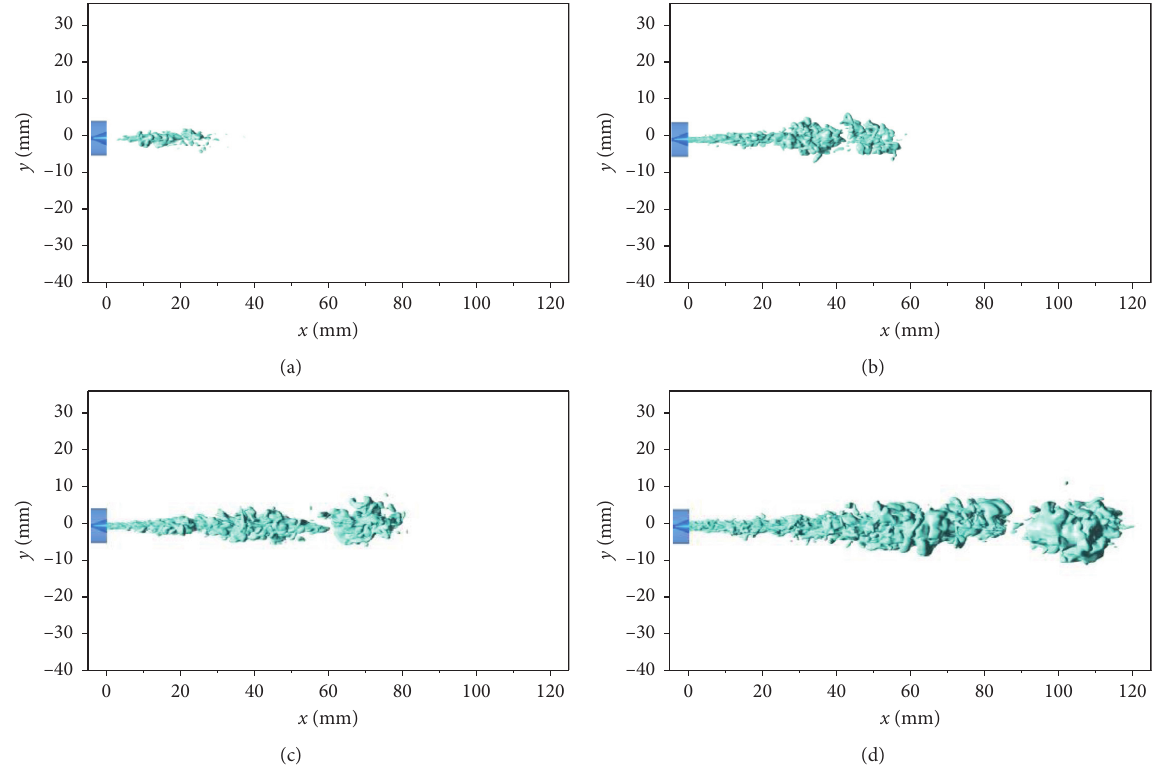
Figure 13: Isosurface of vapor volume fraction of the jet under different cavitation numbers. (a) σ � 0.0203. (b) σ � 0.0101. (c) σ � 0.0068. (d) σ �